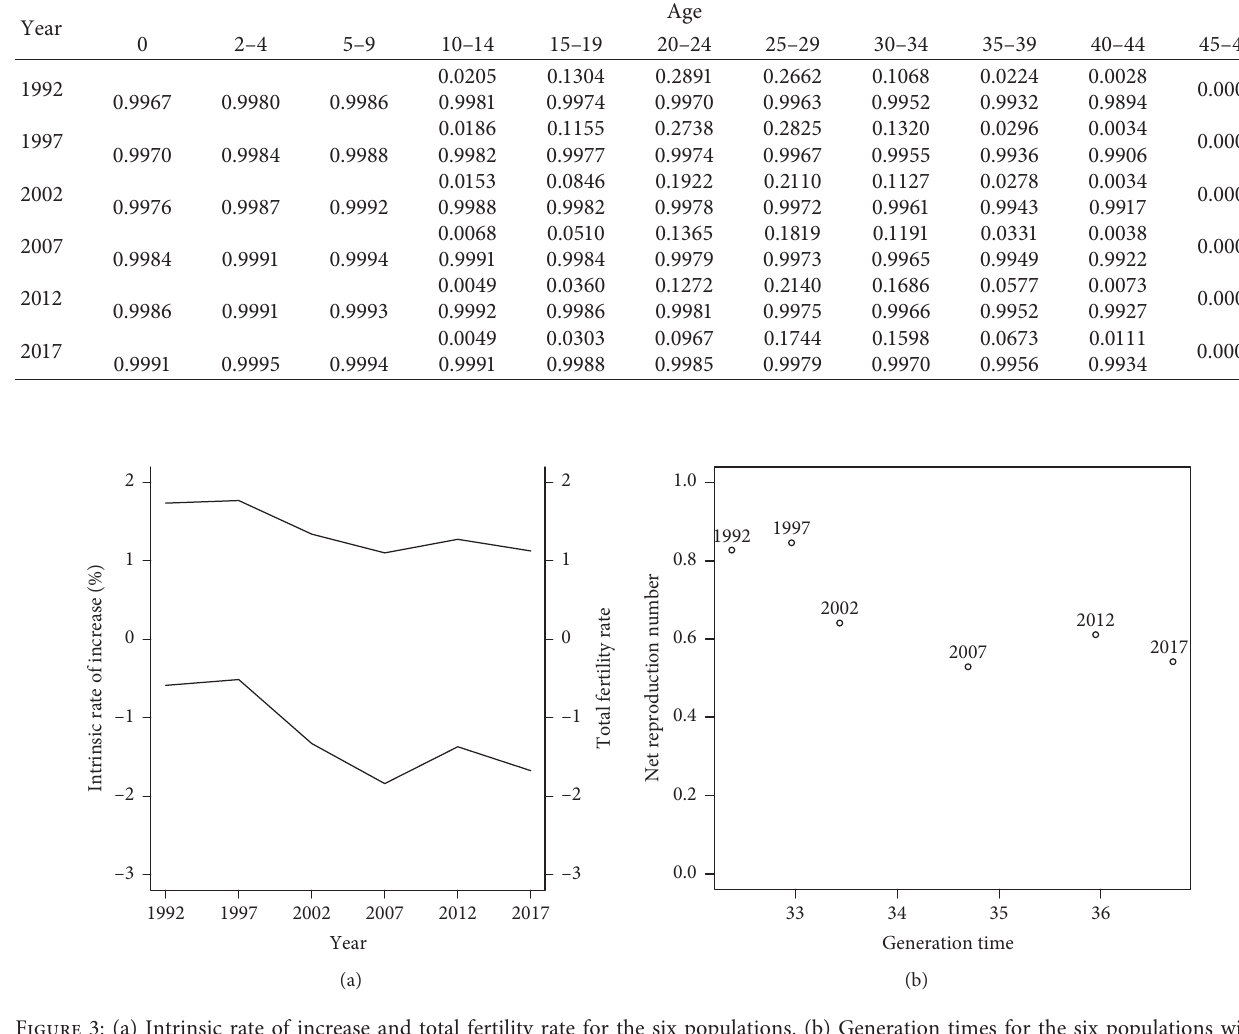
Figure 3: (a) Intrinsic rate of increase and total fertility rate for the six populations. (b) Generation times for the six populations with different net reproduction